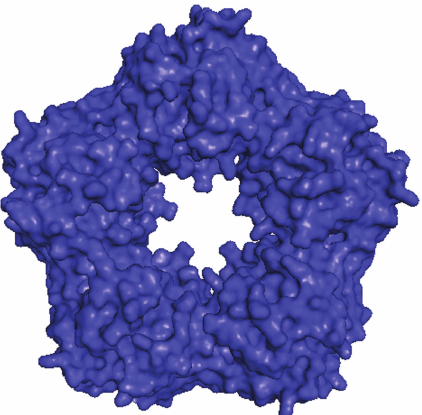
Figure 1: The picture shows the C-reactive protein as it circulates in the human blood stream after response to inflammatory stimuli. The five subunits are forming a disc-shaped pentamer around a central pore. (Picture was generated with information from the RCSB Protein Data Bank by using PyMOL